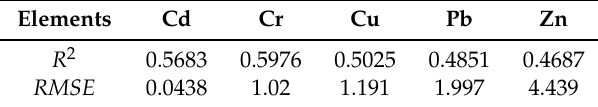
Table 3. The estimation results of the MLR model.